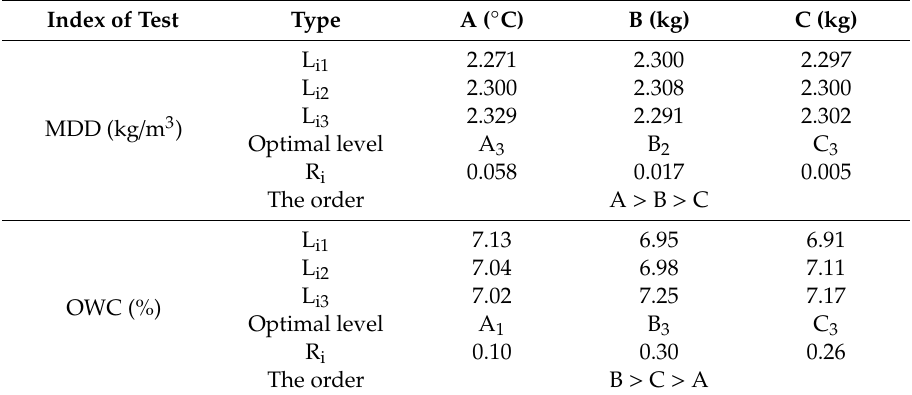
Table 10. The range analysis